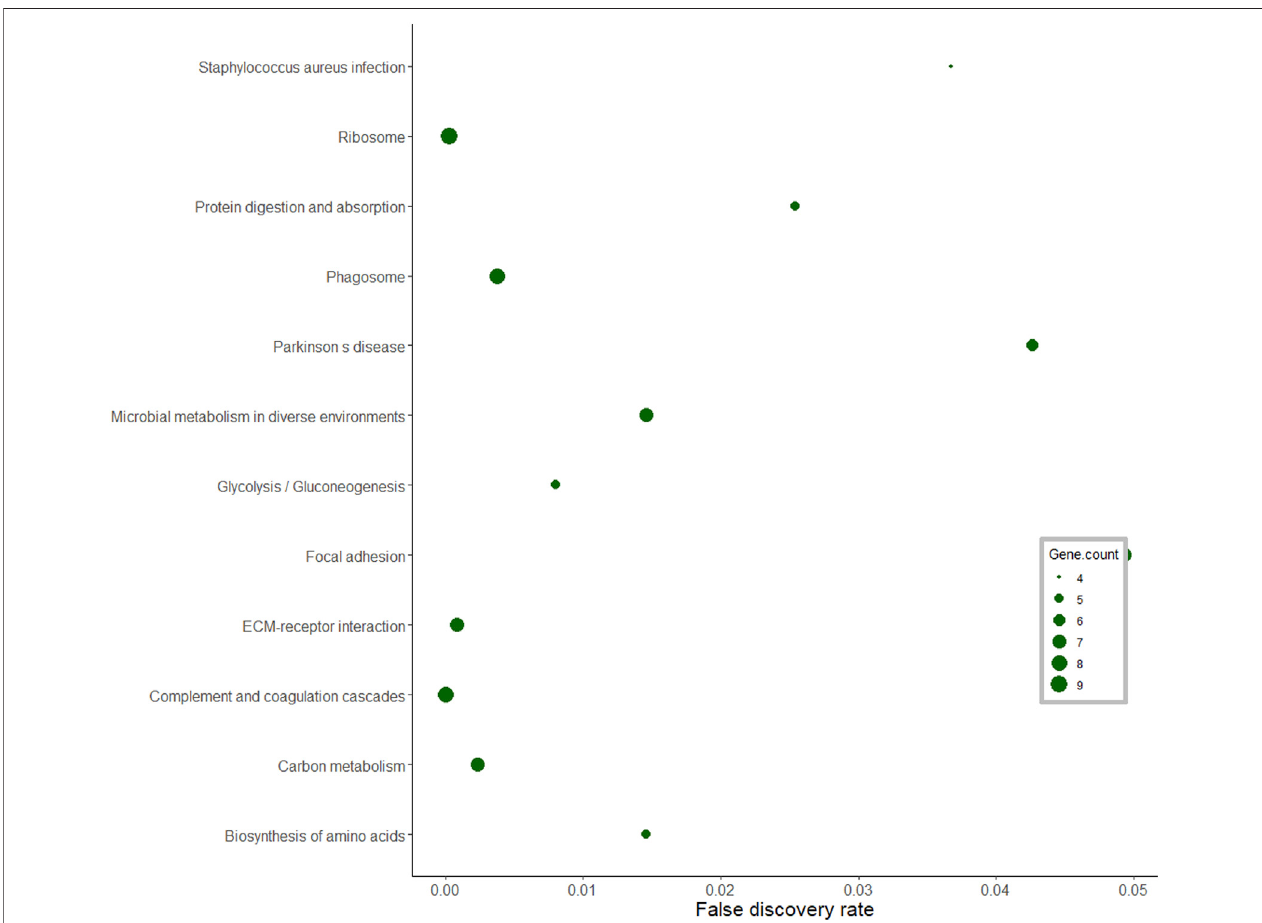
FIGURE 6 | KEGG pathway analysis of differentially abundant proteins in the pituitary gland of pubertal Brahman heifers.